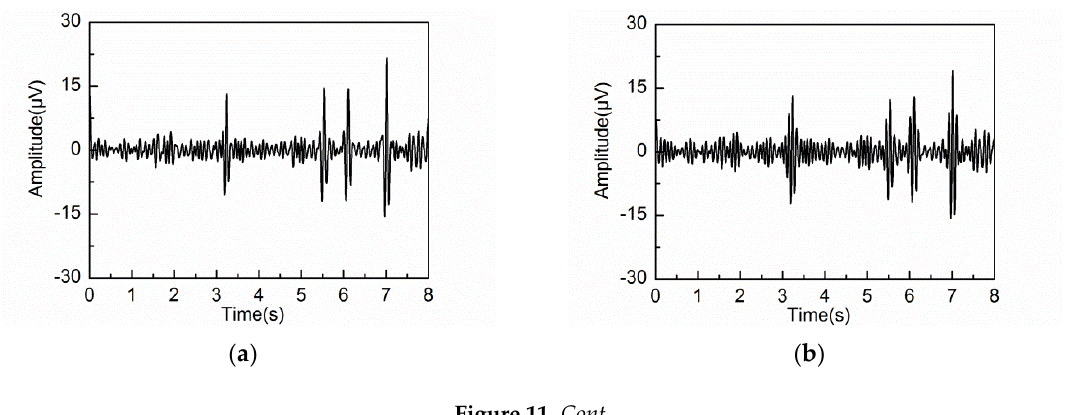
Figure 10. Extracted alpha rhythm under eyes-closed condition: ( a ) L = 20; ( b ) L = 40; ( c ) L = 80; ( d ) PSD of the extracted alpha rhythm by different L.